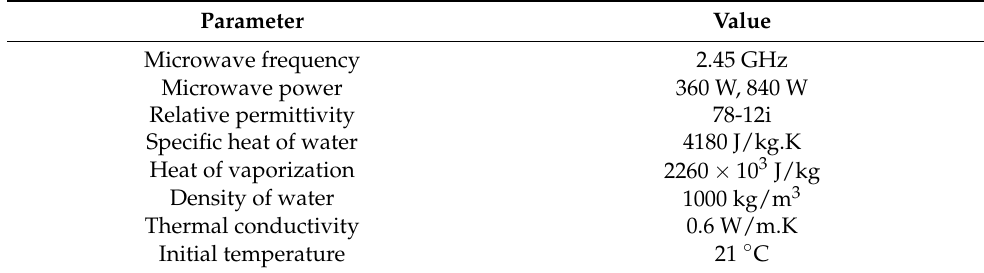
Table 2. Input parameters for microwave heating of